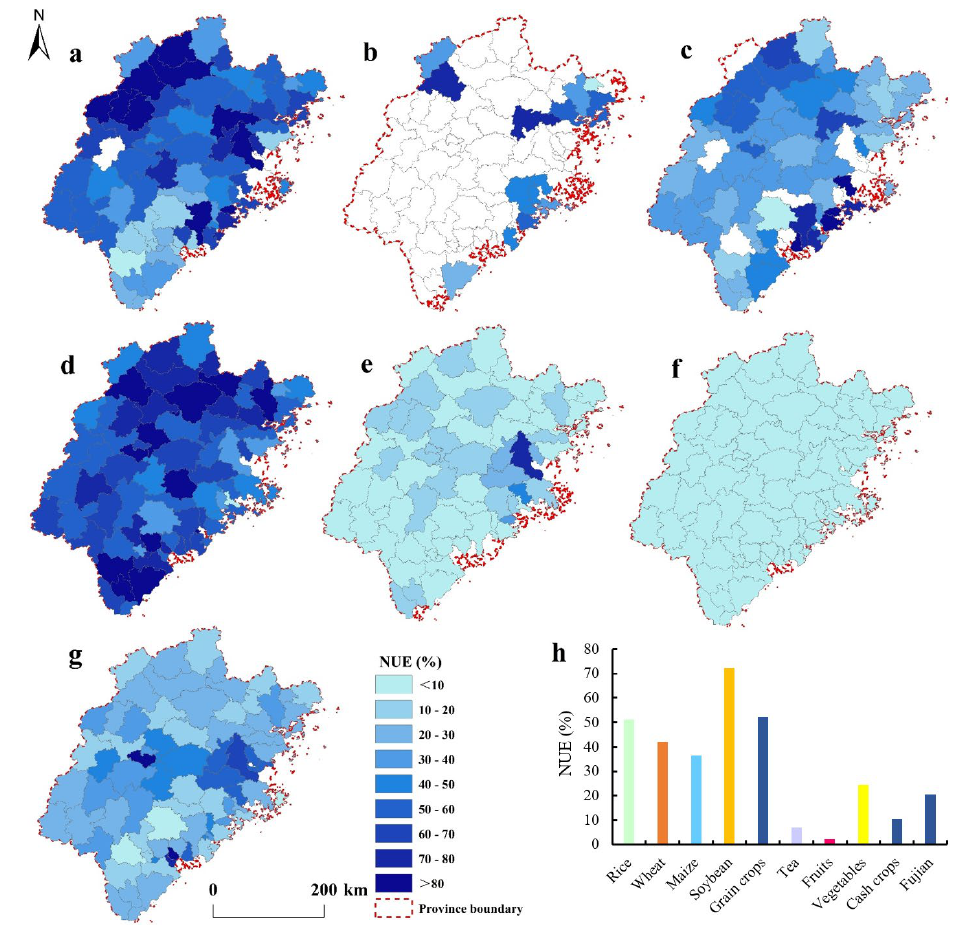
Figure 5. The spatial patterns of NUE of various crops including rice ( a ), wheat ( b ), maize ( c ), soybeans ( d ), tea ( e ), fruits ( f ), and vegetables ( g ) at the county level in Fujian Province, as well as the NUE of various crops in Fujian Province ( h ).